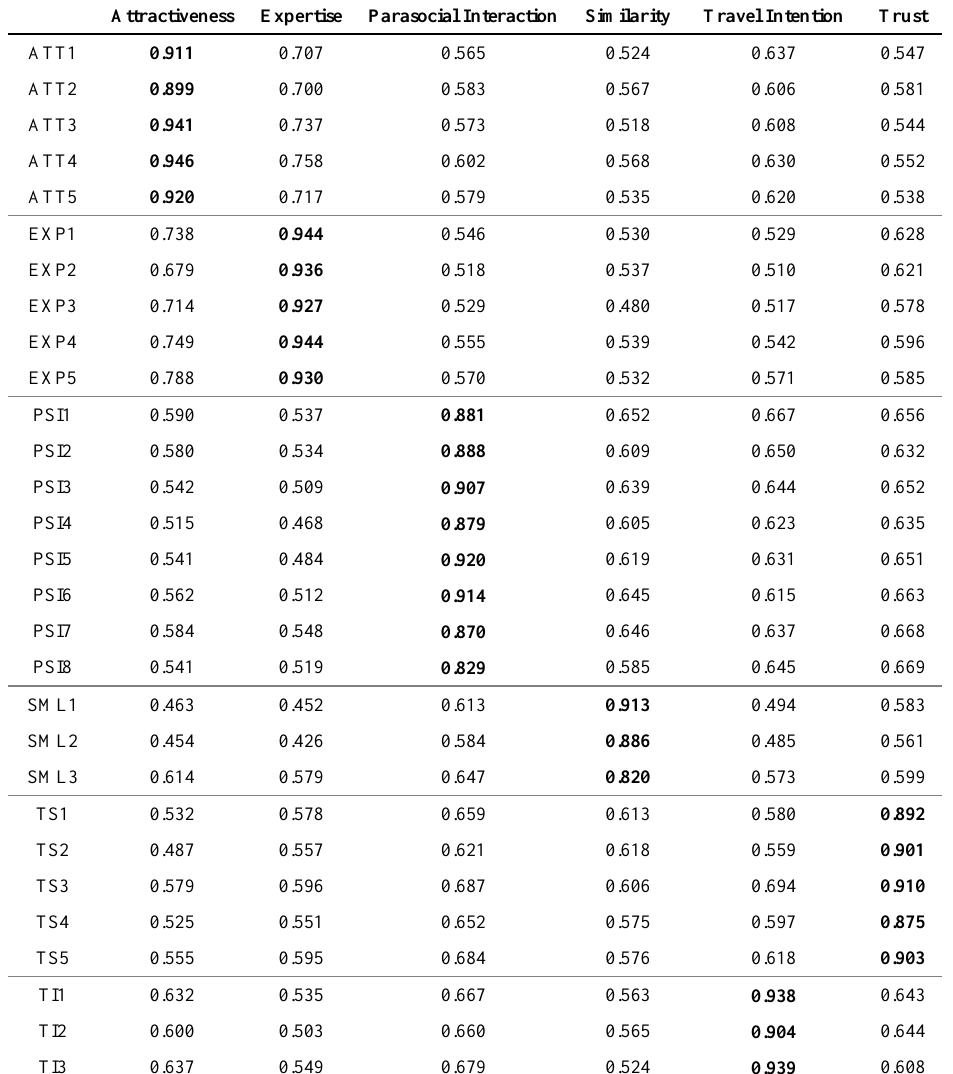
Table 7. Cross-Loadings